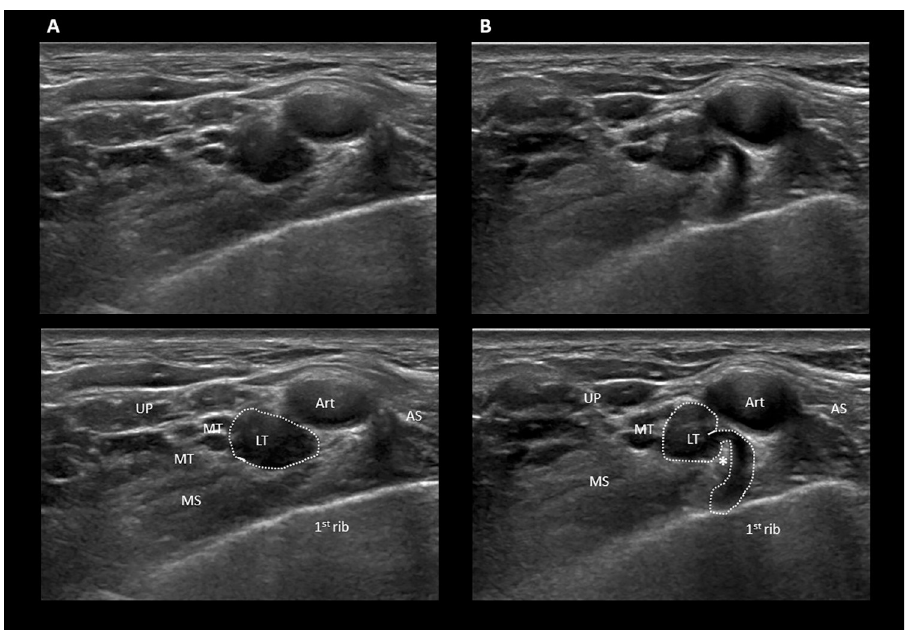
Fig 1. The fibromuscular ‘wedge-sickle sign’. Axial images showing the right brachial plexus in the supraclavicular fossa in patient with neurogenic (supraclavicular) TOS (see also S1 Video). Image B is cephalad relative to image A . In B , note the hyperechoic, ‘wedge’ shaped fibromuscular structure (asterisk) along the caudal medial edge of the middle scalene muscle, indenting (compressing) the lower trunk from the infero-lateral direction, which thus assumes the shape of a ‘sickle’ and becomes swollen and hypoechoic. The fibromuscular structure in this case is a fibrous band connecting the anterior tip of a rudimentary cervical rib (appearing further cephalad as seen in S1 Video) with the first rib (Type 1 Roos ligament). Caudal to the compression ( A ) the lower trunk is still swollen and hypoechoic, but its shape is round. The middle and upper trunks are normal. Note also the medial insertion of the middle scalene muscle on the 1 st rib, forming a V-shaped sling with the anterior scalene muscle and elevating the brachial plexus and the subclavian artery, further restricting space. LT: lower trunk; MD: middle trunk; UP: upper trunk; MS: middle scalene muscle; AS: anterior scalene muscle; Art: subclavian